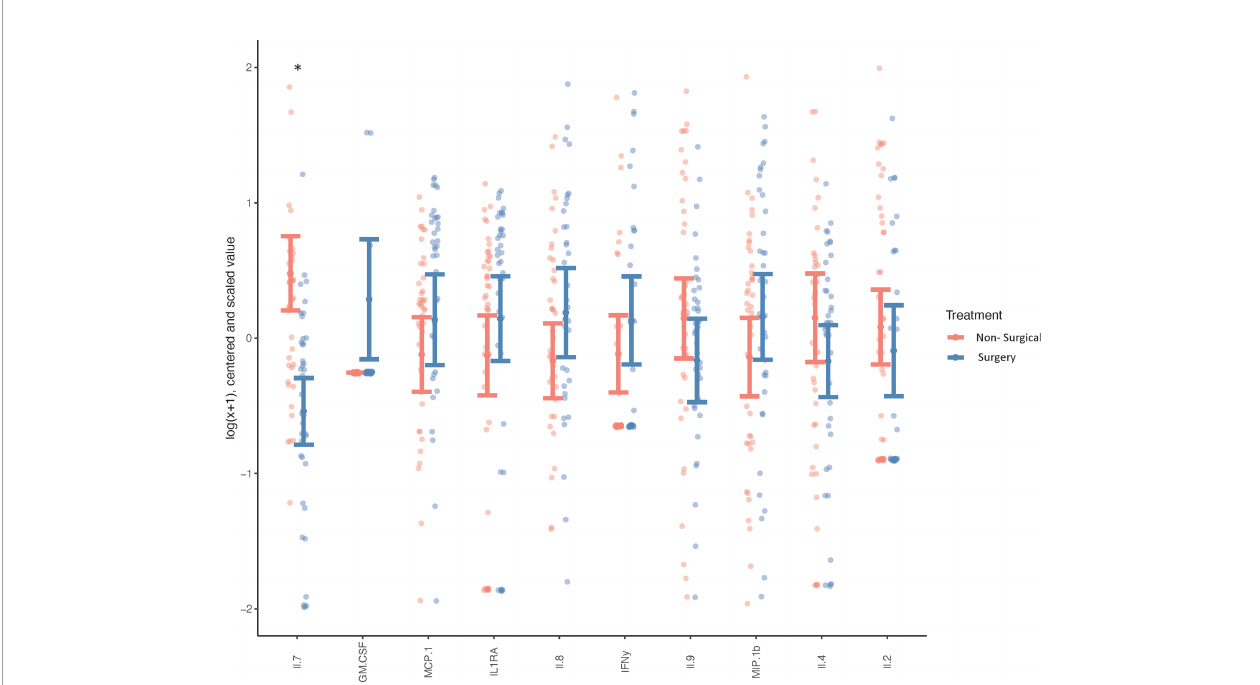
FIGURE 1 | Systemic Cytokine Expression in Surgical vs Non-surgically Managed Patients. Differences in circulating cytokines in the plasma of non-surgically managed (n=44) or surgically managed (n=39) patients at baseline. Wilcoxon test, *p < 0.0001, q < 0.0001, less than 5% of values below lower limit of detection. Adjusted for age, sex, BMI and painful joint count, the y-axis depicts cytokine concentrations (which were log[x+1] transformed, mean-centred and scaled by their respective standard deviation, while cytokines are labelled on the